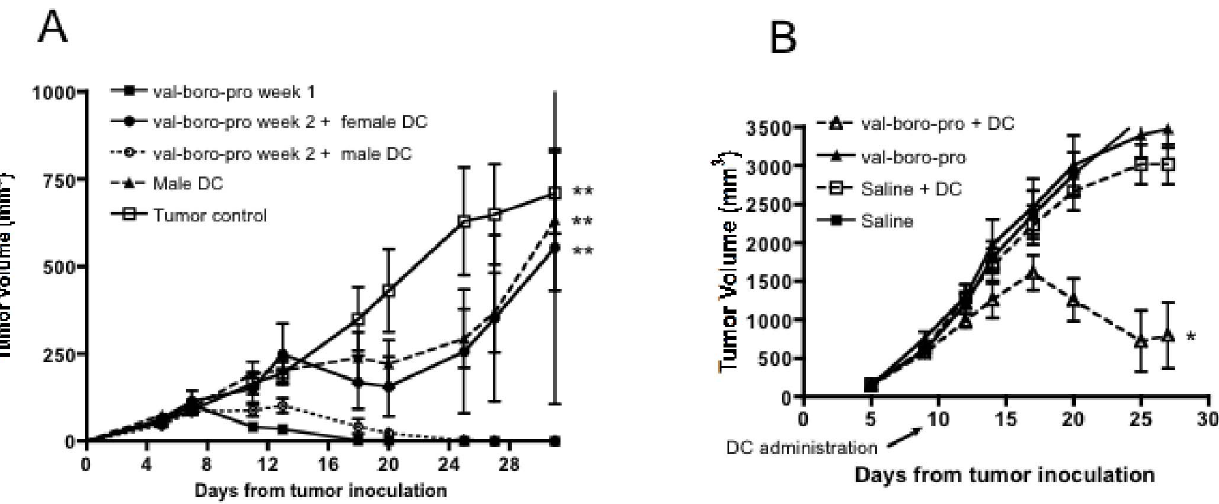
Figure 10. Val-boroPro is an effective adjuvant to tumor primed dendritic cell vaccination. (A) C57BL/6 female mice were challenged with MB49 (1 6 10 6 ) on day 0 and treated with 20 m g Val-boroPro or saline from days 3–7 (closed squares) or 10–14 (n=5/group). On day 12, late- treatment groups received either a male-derived HY-expressing DC vaccine or a female-derived DC vaccine IP (1 6 10 5 ). Tumors were significantly smaller in mice receiving male DC vaccine plus Val-boroPro during week 2 (open circles) compared to no treatment (open squares), male DC alone (closed triangles) or female DC plus Vale-boroPro during week 2 (closed circles) (p , 0.01, Anova with Tukey post-test) (B) C57BL/6 mice were injected intramuscularly with M3-9-M and treated with Val-boroPro starting on day 10. Bone marrow-derived DCs pulsed with irradiated M3-9-M were given IP on day 12 (n=8/group). Tumors were significantly smaller in mice receiving combined treatment (open triangles) compared to no treatment (closed squares) or either treatment alone (open squares or closed triangles) (p , 0.01, Anova). Figures 7A and 7B are both representative of 2 experiments.